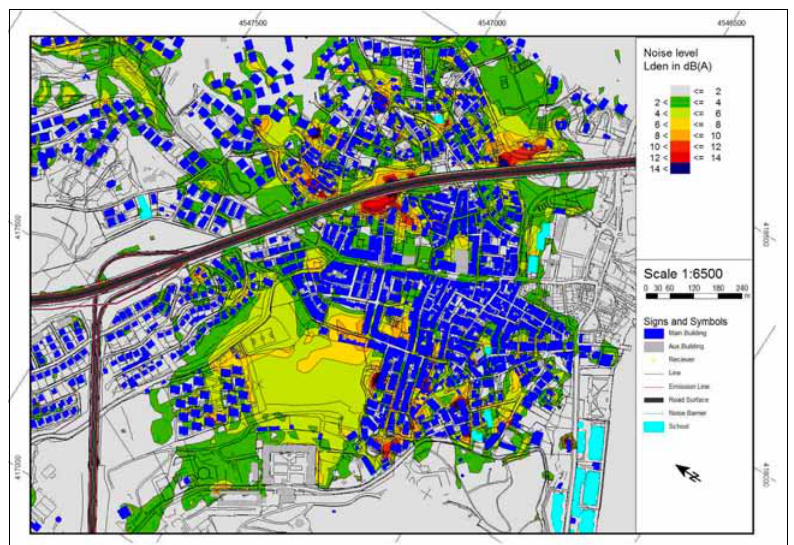
Fig. 8. Reduction in the level of exposure obtained with the addition of noise barriers to the model